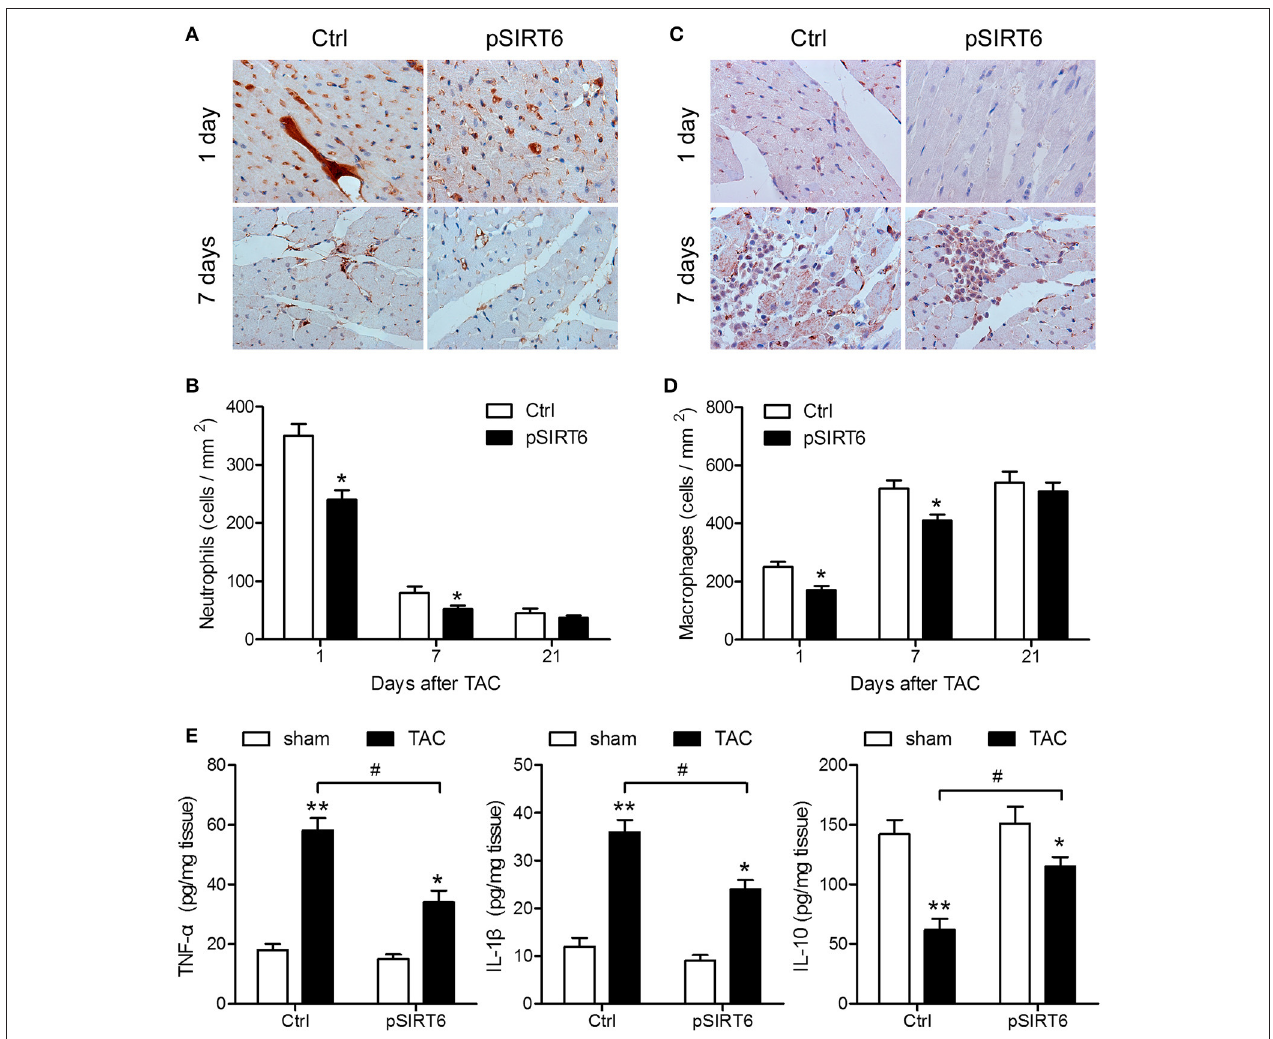
FIGURE 4 | SIRT6 overexpression decreases TAC-induced myocardial inflammation. (A) Representative images of neutrophil (Ly6G + cell) infiltration in control and pSIRT6-injected mice at 1 and 7 days after TAC surgery are shown at 400 × magnification. (B) Quantification of infiltrated neutrophils per area in frozen sections of infarcted hearts at different time points after TAC surgery. (C) Representative images of macrophage (CD68 + cell) infiltration in control and pSIRT6-injected mice at 1 and 7 days after TAC surgery are shown at 400 × magnification. (D) Quantification of infiltrated macrophages per area in frozen sections of infarcted hearts at different time points after TAC surgery. * P < 0.05 vs. Ctrl group. n = 8 per group. (E) Levels of TNF- α , IL-1 β , and IL-10 measured in the heart homogenate of control and pSIRT6-injected mice after TAC or sham surgery for 24 h. * P < 0.05, ** P < 0.01 vs. sham group, # P < 0.05. n = 8 per